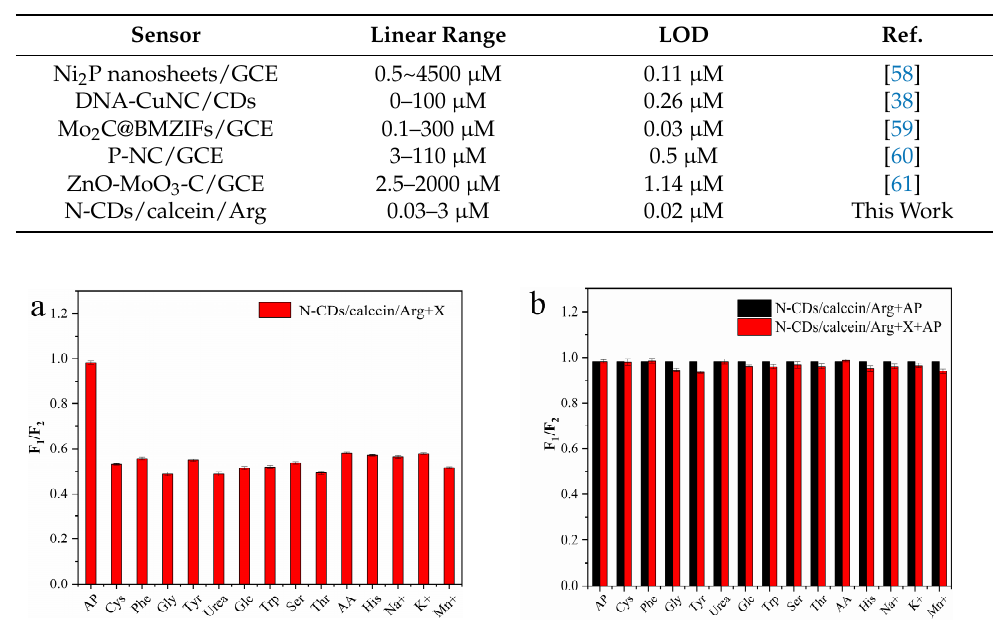
Figure 14. ( a ) F 1 /F 2 ratio of N-CD/calcein/Arg complex system on AP and other substances’ detection; ( b ) F 1 /F 2 ratio of N-CD/calcein/Arg complex system on AP detection with or without interference substances.